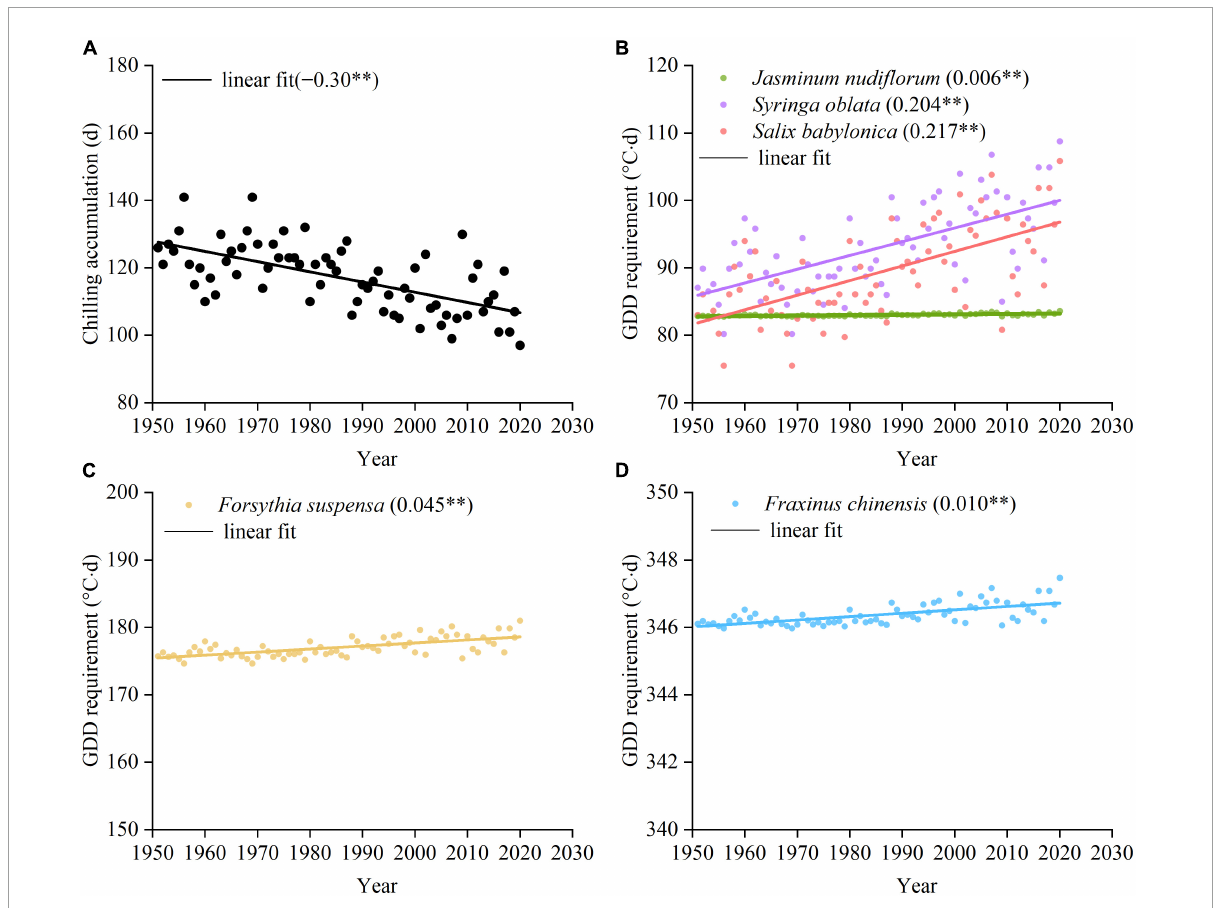
FIGURE6 Chilling accumulation and growing degree day requirement (GDD R ) of spring events over the past 70 years. The GDD R is simulated by the exponential function between GDD R and CA (Equation 4). (A) Chilling accumulation of five species. (B) GDD R of J. nudiflorum , S. oblata , and S. babylonica , (C) GDD R of F. suspensa , and (D) GDD R of F. chinensis . The linear slope and significance level for each species are shown in parentheses. ∗∗ p <